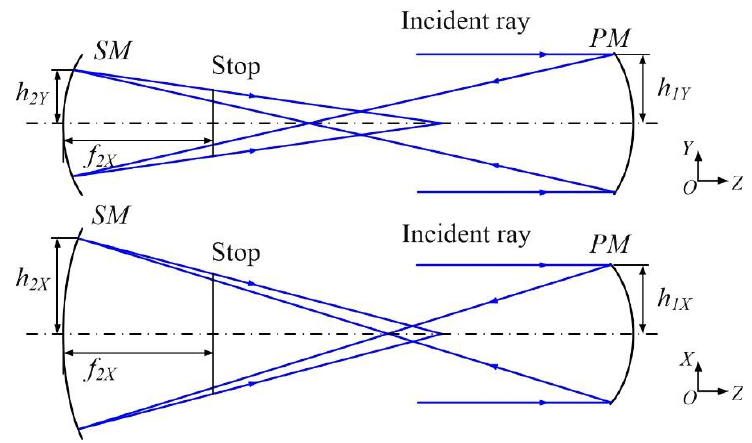
Figure 2. Schematic diagram of the anamorphic system in the X and Y directions.